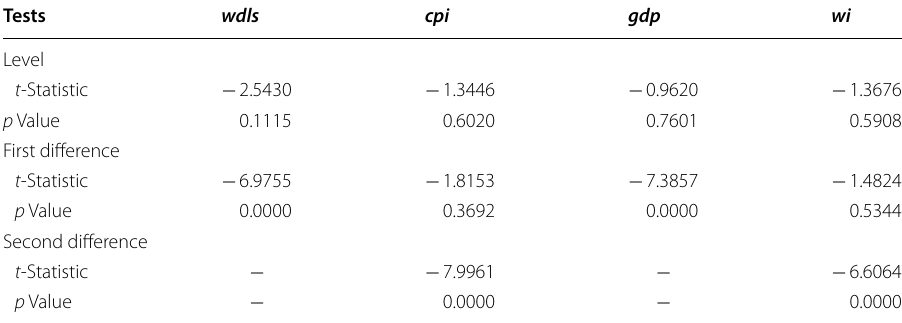
Table 2 Results of ADF unit root test Source : Data were derived from Ministry of Labor and Social Security, ÇSGB. In Turkish, Grev ve Lokavt uygulamaları, see the link (http://www. csgb.gov.tr/csgbP ortal /csgb.porta l?page grevl okavt ) accessed on January 20, 2016 =